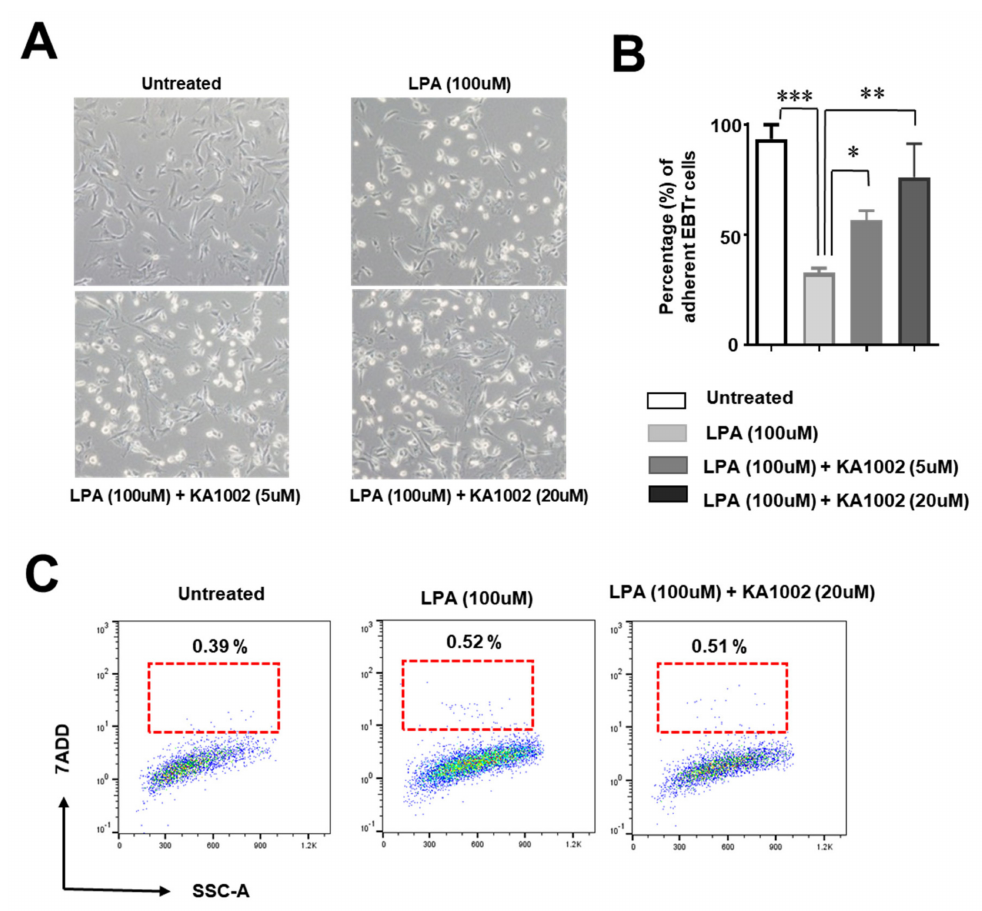
Figure 4. EBTr cells were treated with 100 µ M LPA, or 100 µ M LPA + 20 µ M KA-1002 for 18 h. ( A ) Representative images of each group were obtained using light field microscopy. ( B ) Graphical analysis of the ratio of unattached cells to adherent cells in four di ff erent experimental images. * p < 0.05, ** p < 0.01, or *** p < 0.001 01 indicates significant di ff erences in comparison to untreated control